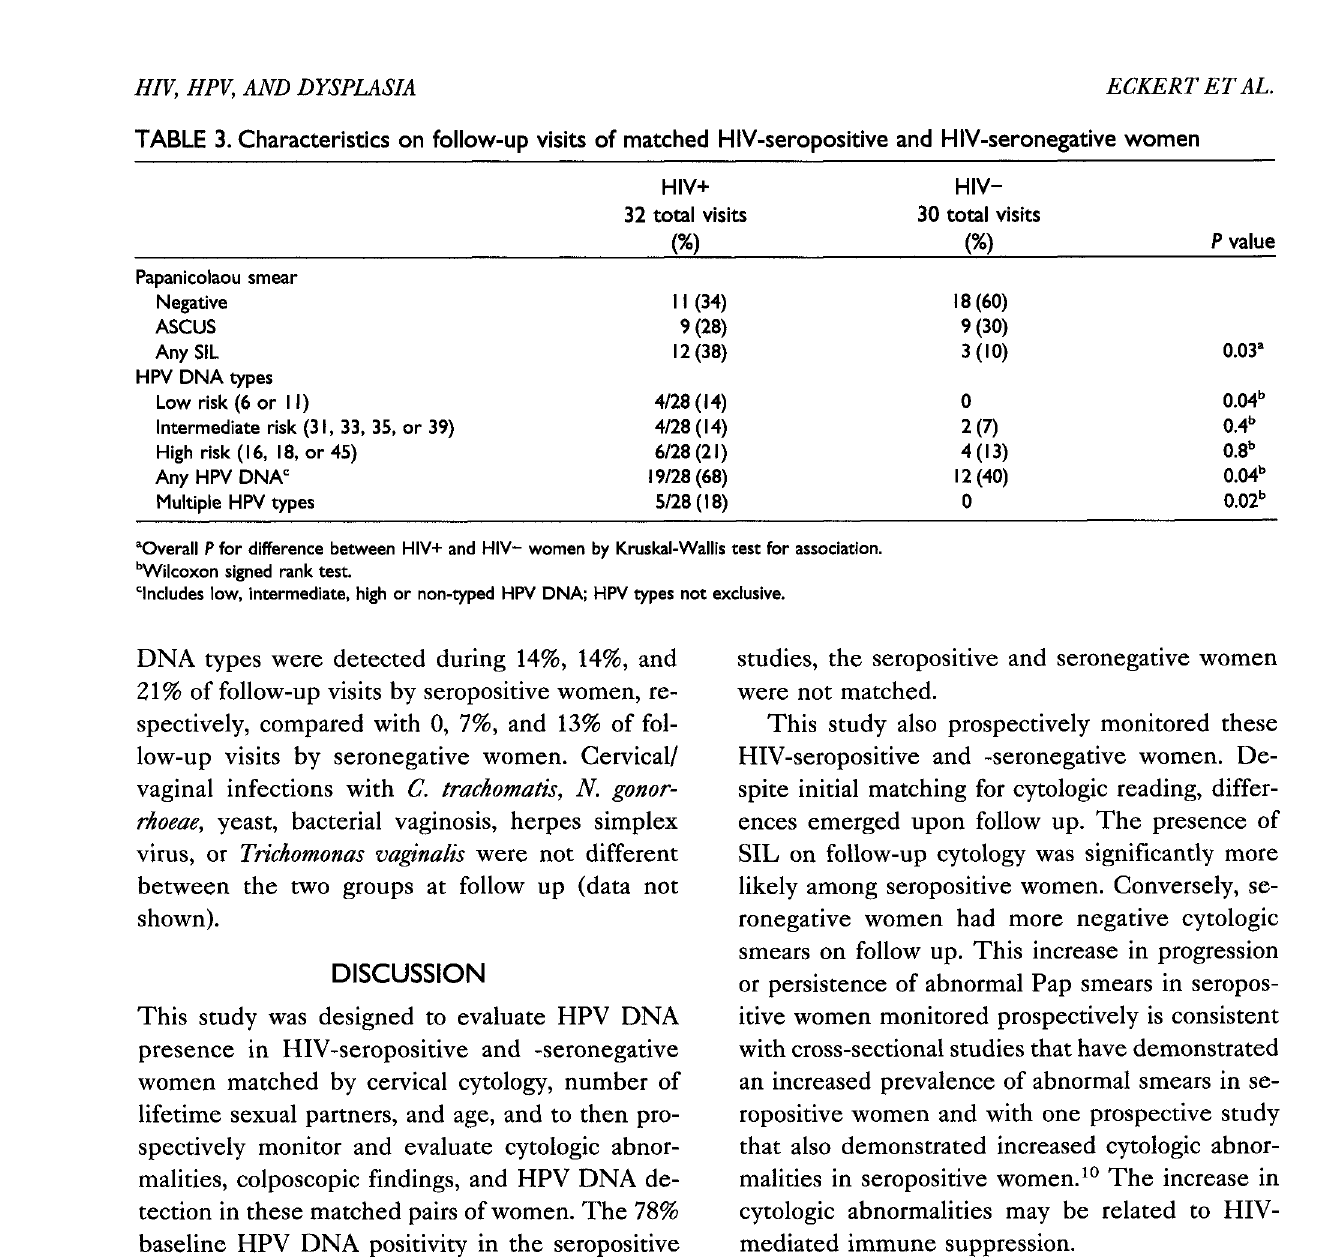
TABLE 3. Characteristics on follow-up visits of matched HIV-seropositive and HIV-seronegative women